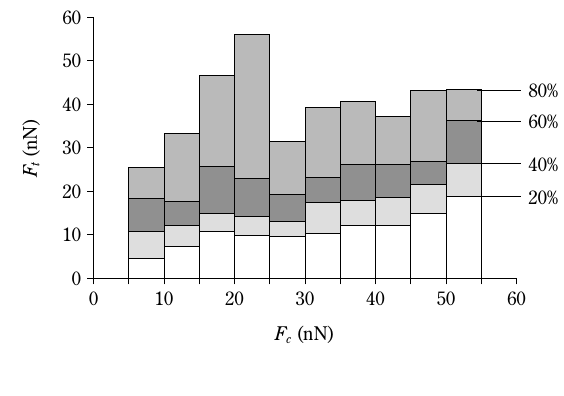
Statistical distribution of the adhesive force (Ft) between two irregularly shaped toner particles with low surface addi- tive coverage as a function of the load force (Fc). Forces are measured using a Scanning Force Microscope. The vertical bars indicate the cumulative distributions of the experimental measurements for every range of load